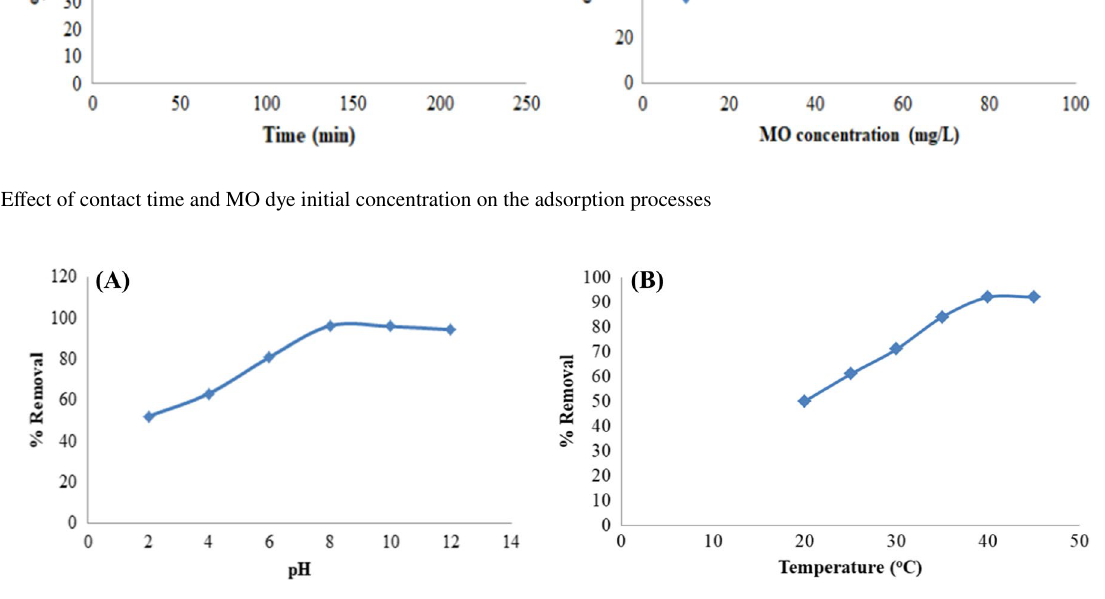
Fig. 4 Effects of pH at 25 °C and temperature variation on the adsorption of MO onto Anchote peel